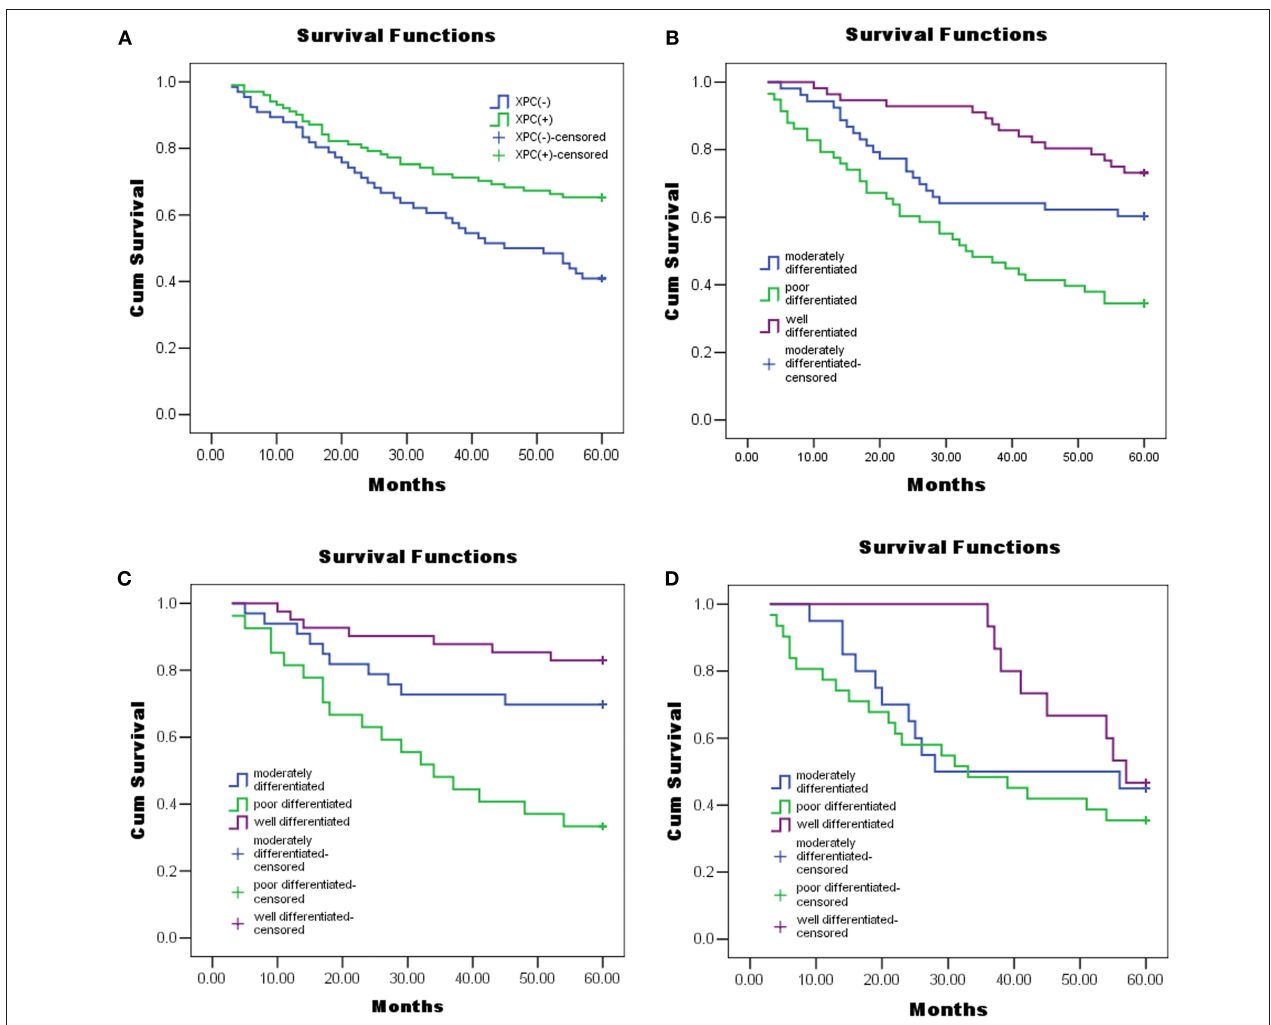
FIGURE 6 | XPC expression and colorectal cancer patients’ overall survival. Kaplan–Meier Curves using log rank tests for the overall survival of colorectal cancer patients was evaluated. (A) The overall survival of colorectal cancer patients with XPC( − ) and XPC( + ). (B) The overall survival of colorectal cancer patients with different degrees of differentiation. (C) The overall survival of colorectal cancer patients with high XPC expression in different degrees of tissue differentiation. (D) The overall survival of colorectal cancer patients with attenuated XPC expression in different degrees of tissue differentiation. Cum,